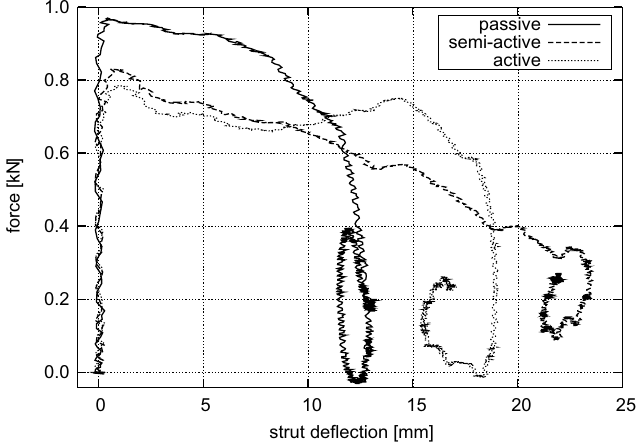
Fig. 21. Measured force versus deflection at the passive, semi-active and active control strategy for m = 37 kg and v 0 = 0 . 79 m / s (drop height 32